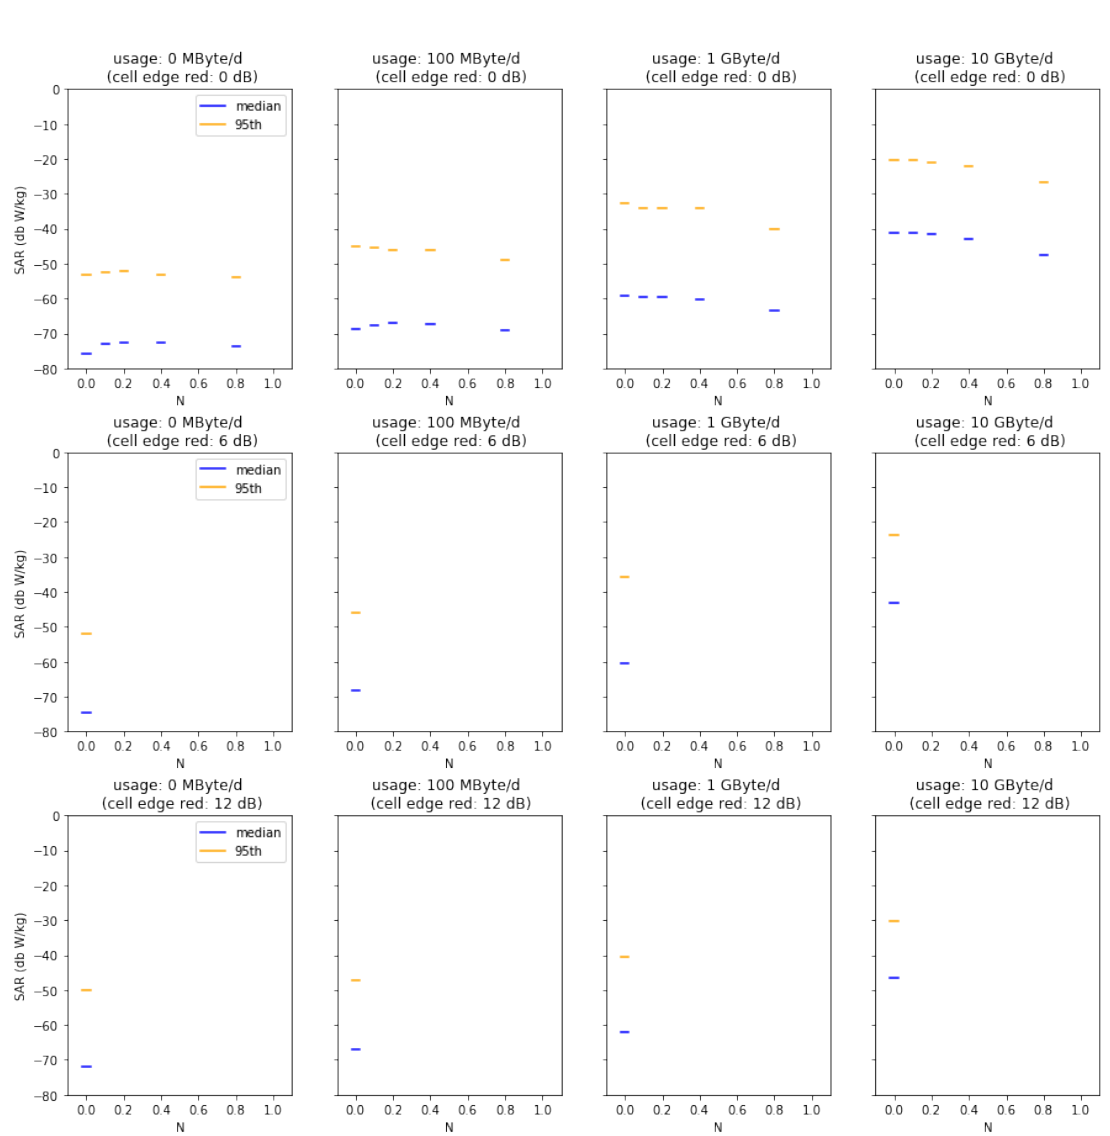
Figure A1. Median and 95th percentiles for varied usage, indoor coverage factor N , and cell size reductions in the rural cell